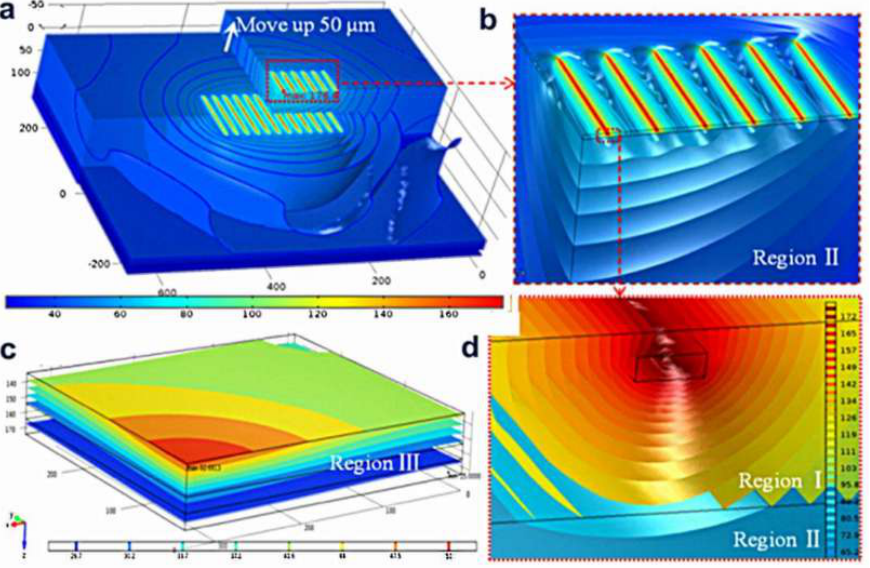
Figure 6. ( a ) The actual module, ( b ) Near-junction region, ( c ) Heat sources region, and ( d ) Tempera- ture distribution and isothermal surface of solder and water